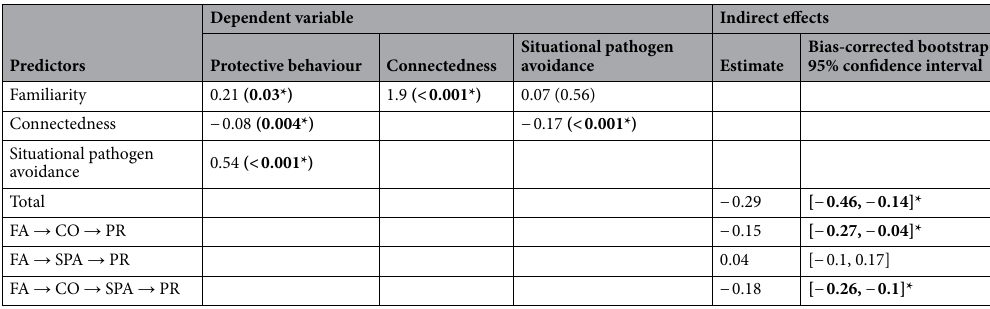
Table 4. Mediation analyses model 4. In study 2, two mediation models with two mediators (connectedness and disgust) were calculated. Mediation model 2 refers to the outcome variable own protective behaviour. Table 4 shows the direct effects (β) in the mediation models and the indirect effects in mediation model 4. p-values less than 0.05 are assumed to be significant (*). An indirect effect is assumed as significant if the 95% CI does not include 0